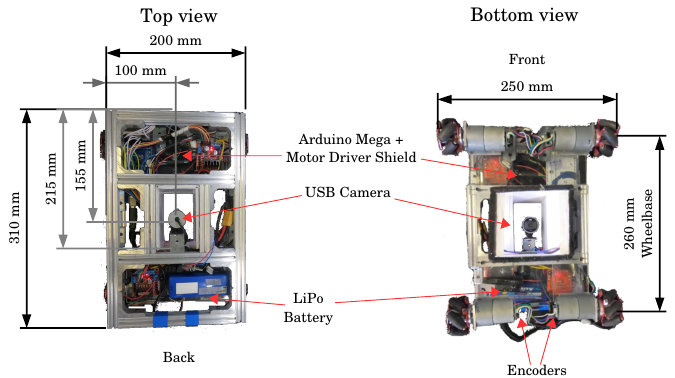
Figure 2. AGV prototype top and bottom views showing its dimensions and components location.